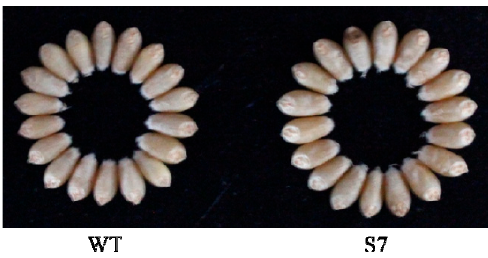
Figure 4. Comparison of phenotype of mature grains between WT and the representative transgenic wheat lines. Eighteen grains were randomly selected in WT and S7 line, respectively. Table 1. Comparisons of grain characterizations between WT and transgenic wheat lines in the field. Lines